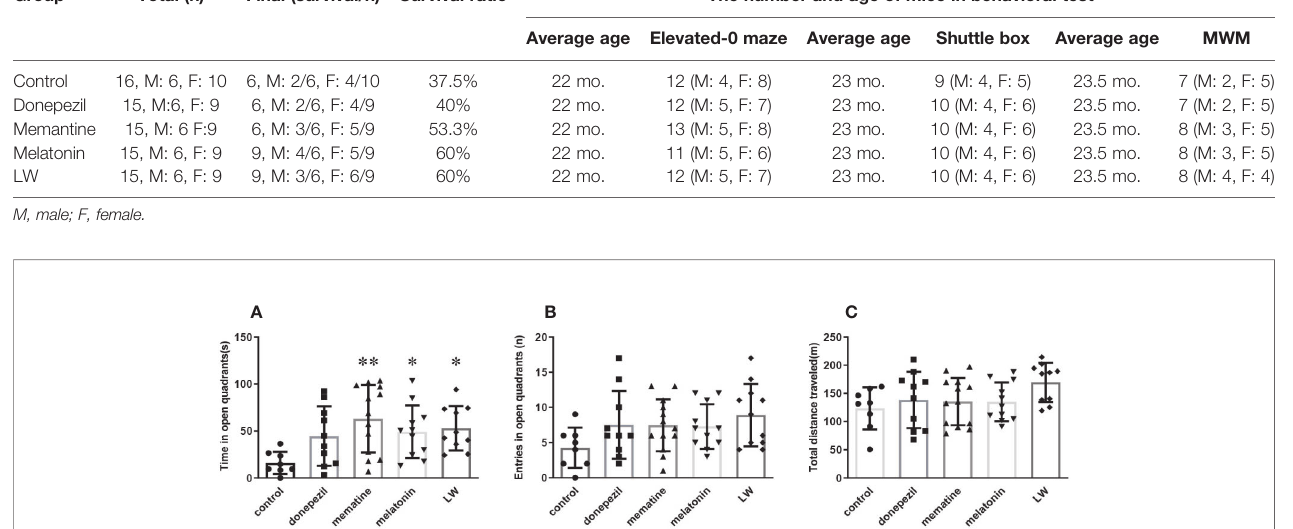
TABLE 1 | The number of mice in every behavioral test and the fi nal survival mice. Group Total (n) The number and age of mice in behavioral test Average age Elevated-0 maze Average age Shuttle box